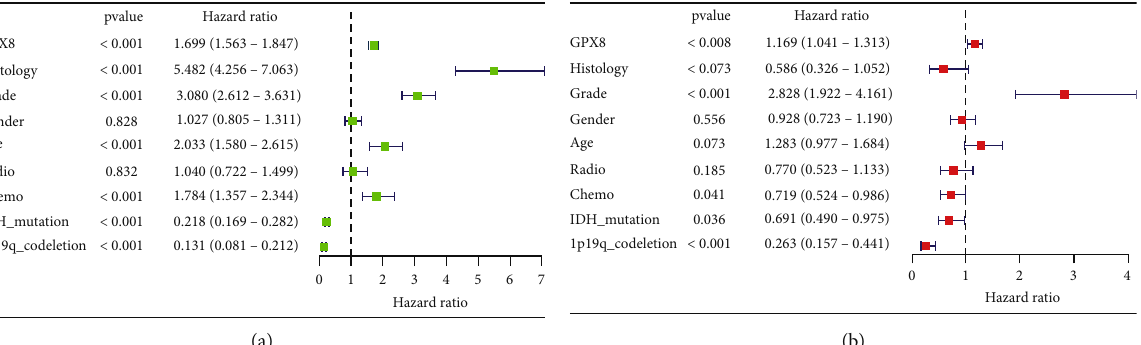
Figure 3: Relationship between clinical characteristics and prognosis of patients with primary glioma ( n = 502 ) from CGGA database. (a) Univariate analysis. (b) Multivariate